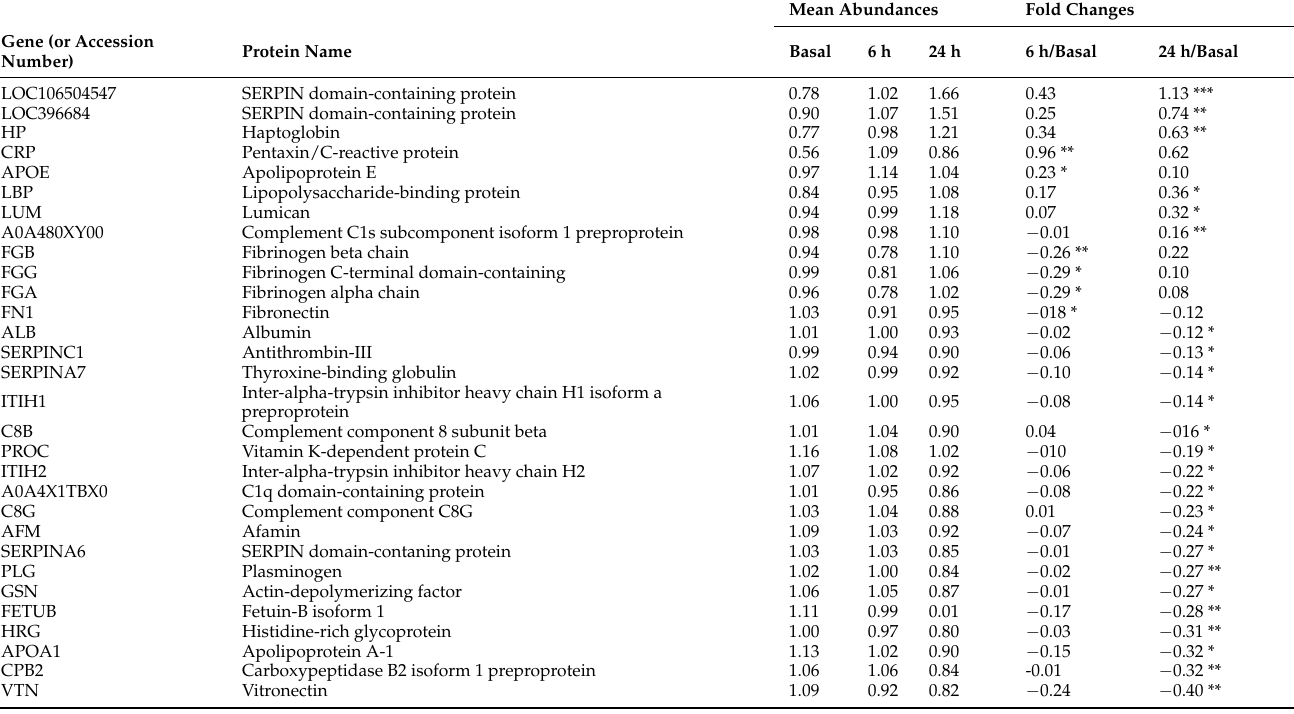
GO analysis enriched 34 GO terms among the altered serum proteins (full list in Supplementary Table S2). Downregulated proteins were more associated with cysteine- type endopeptidase activity (GO:0004197), vitamin transport (GO:0051180) or